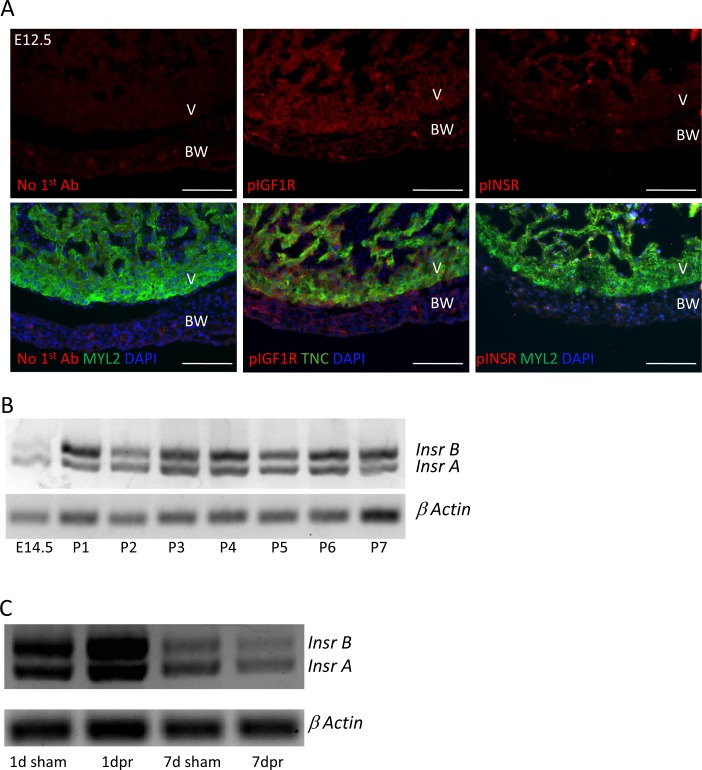
IGF1R and INSR expression and activation.(A) Staining of embryonic day E12.5 hearts with the same anti-phospho-specific receptor antibodies as used in Figure 4 and Figure 4—figure supplements 1 and 2, showing positive reactivity for pIGF1R and only faint signal with pINSR. This result repeats what we have shown previously (Wang et al., 2019); the sections shown here were newly stained in this study and done alongside those shown in Figure 4. (B,C) Expression of the two Insr splice variants, detected by RT-PCR using primers from the two common exons that flank the included or excluded exon, over developmental and postnatal time in uninjured hearts (B) and unchanged by P1 injury (C).